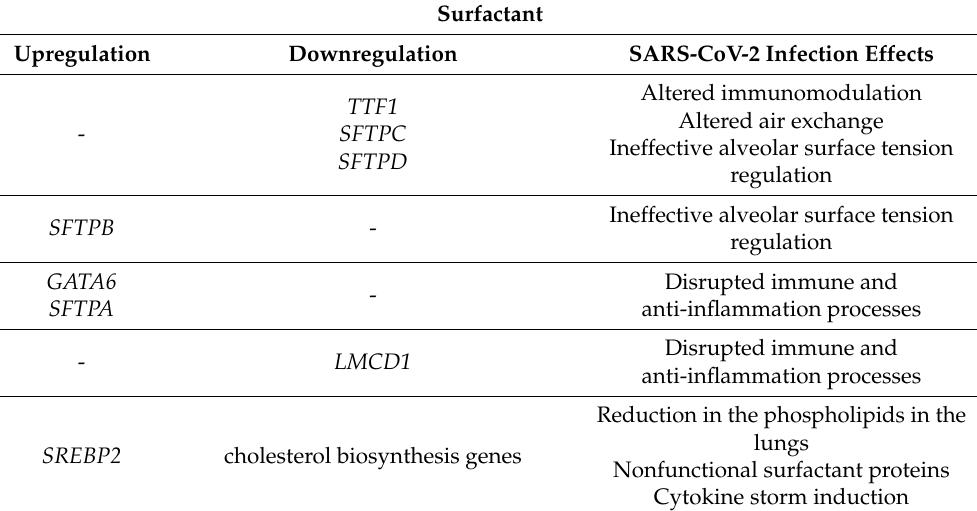
Table 1. Processes in the COVID-19 lungs related to surfactant